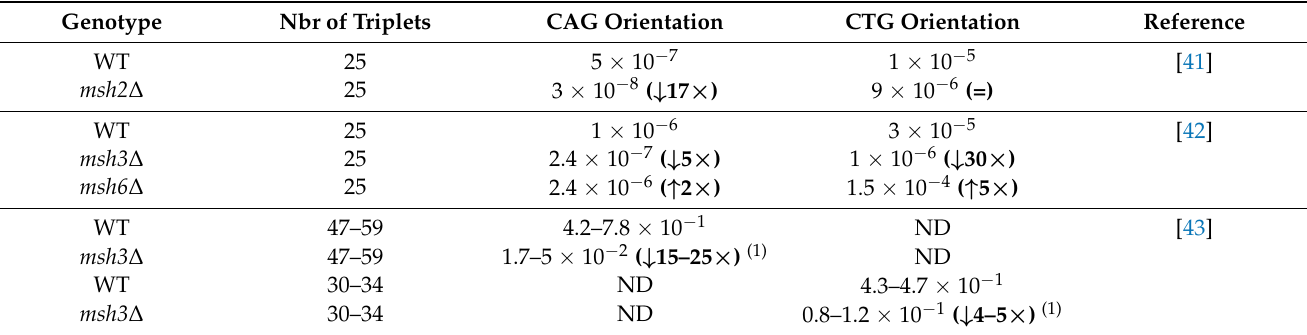
Table 1. Trinucleotide repeat expansions per cell division in yeast mismatch repair mutants. Genotype Nbr of